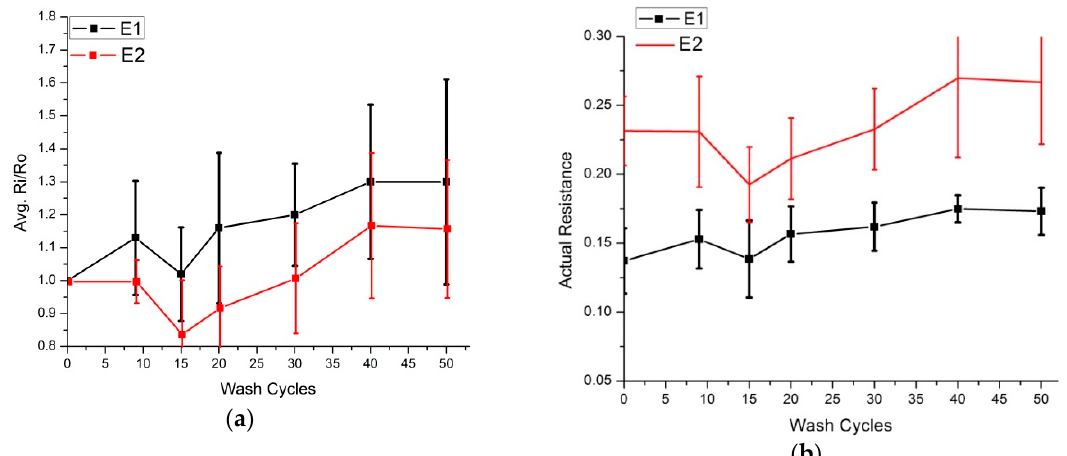
Figure 11. Surface resistance analysis (express wash), four samples of each electrode were tested, ( a ) Comparison of Ri/Ro ( b ) Comparison of actual resistance.